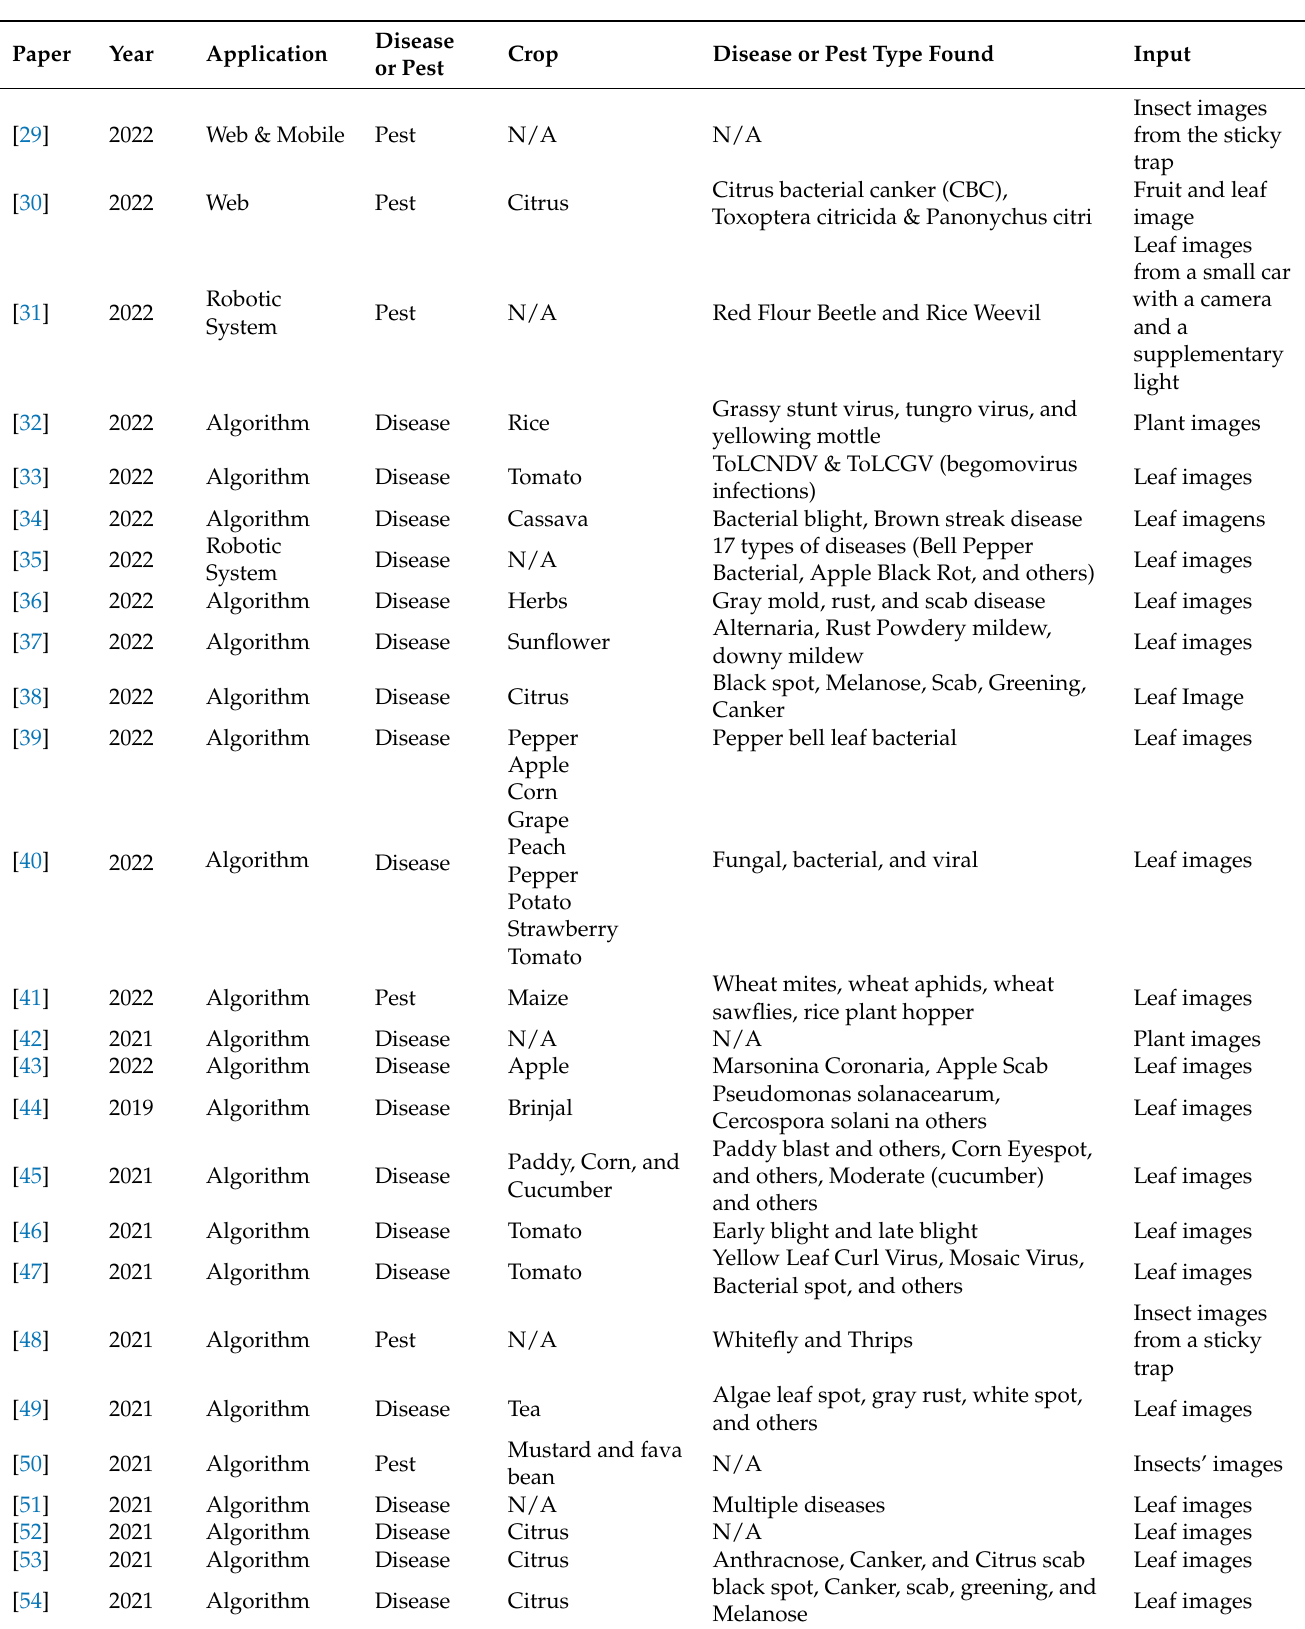
Table 2. Summary of the articles selected for analysis and